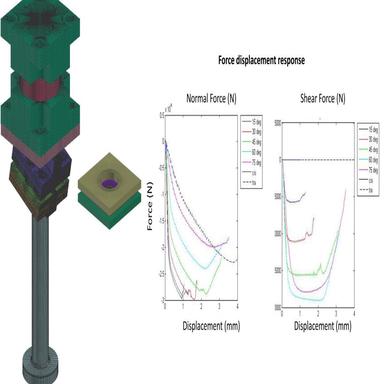
Overview of FE simulations carried out.